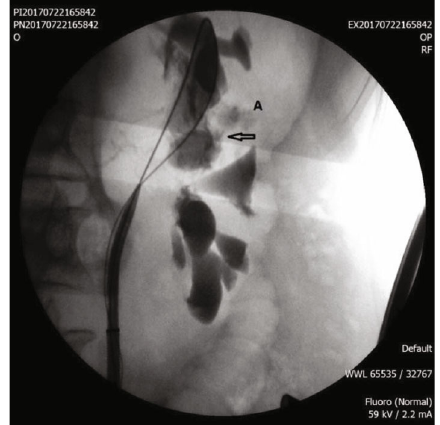
Figure 2: A: stone-containing calyceal diverticula. Arrow: opaci fi ed neck of a calyceal diverticulum.